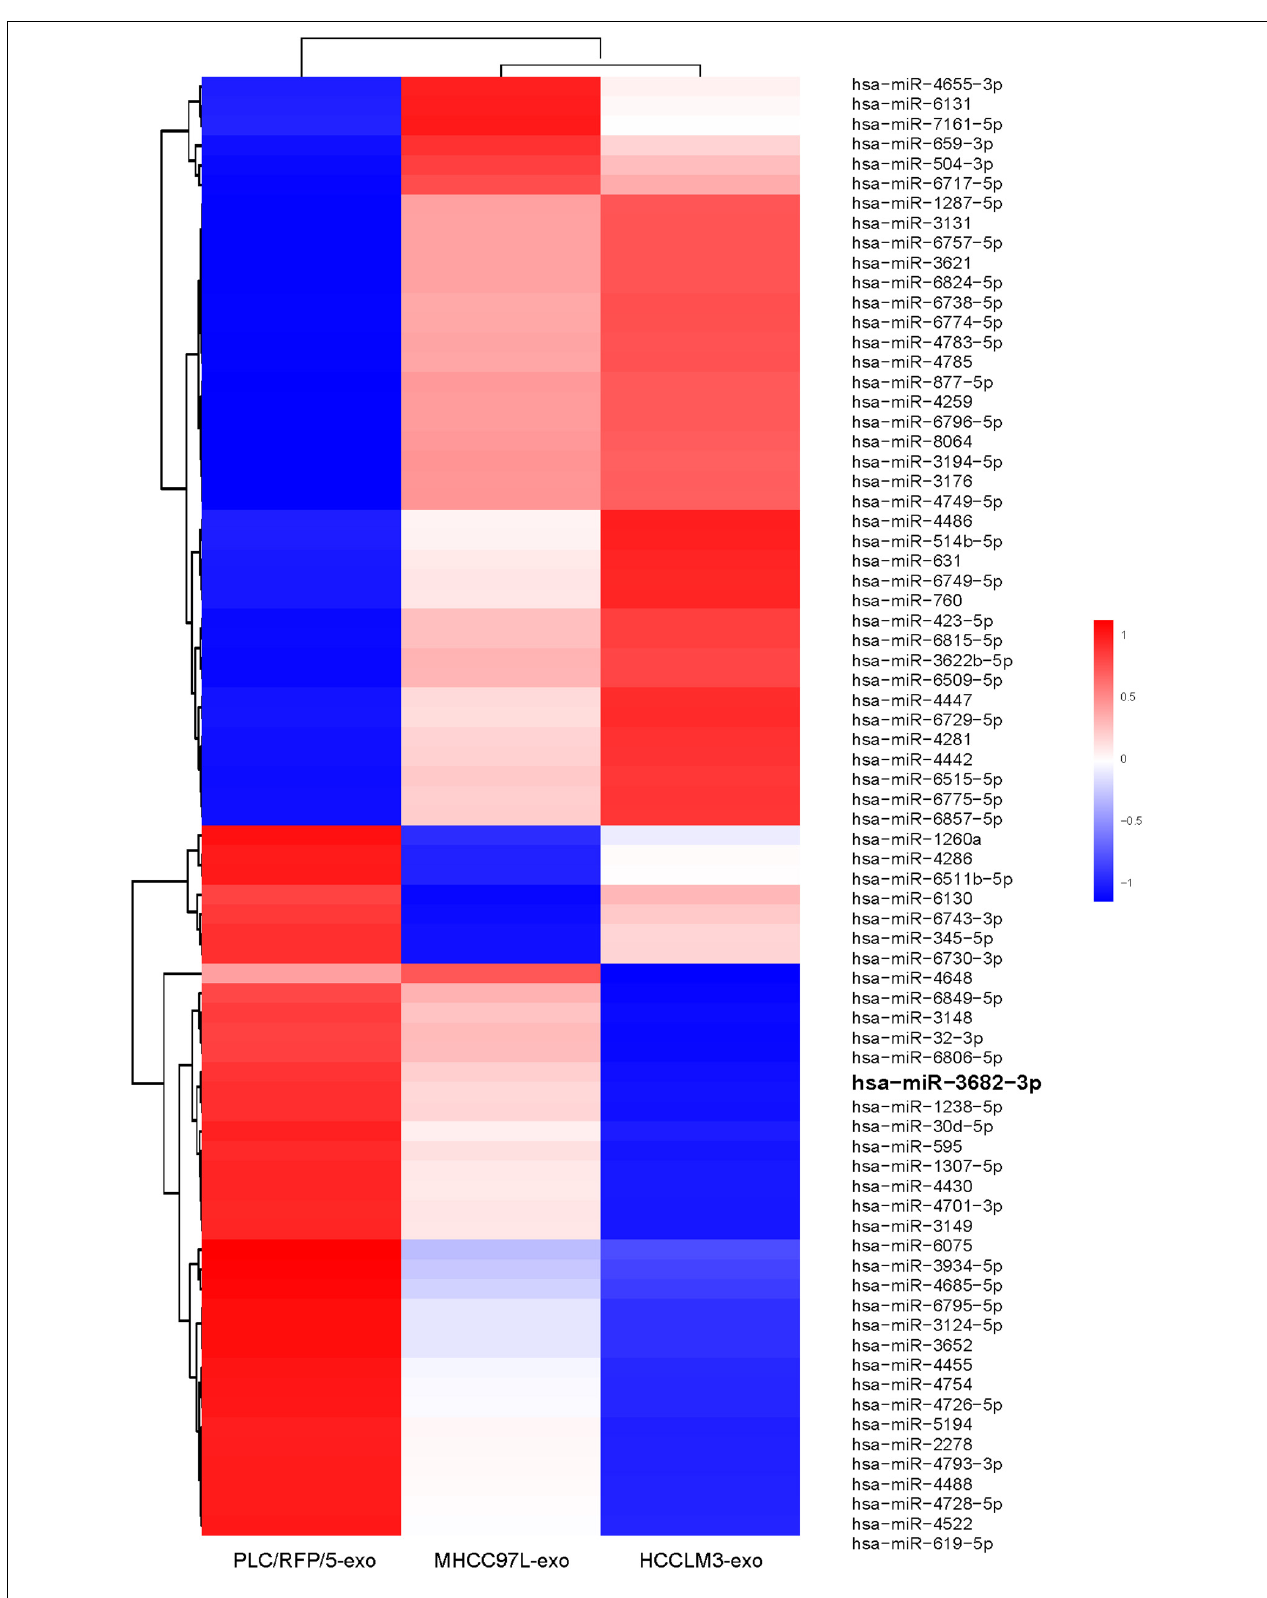
FIGURE 4 | Microarray analysis of exosomal miRNAs from different liver cancer cells were presented in a heatmap.